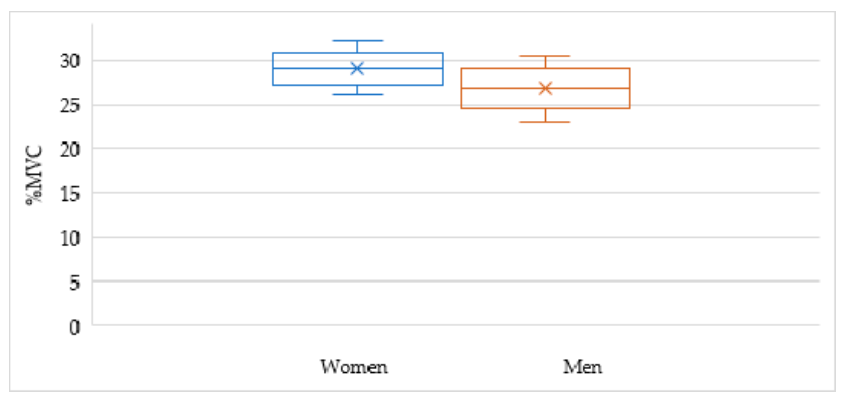
Figure 4. A frame-whisker chart of load distribution in the forearms generated by the examined farmers.